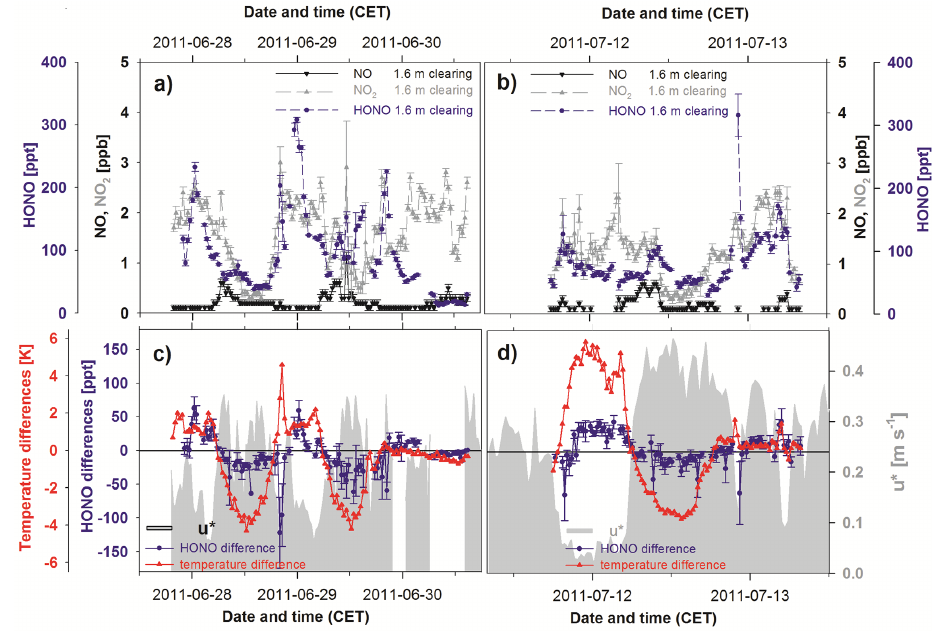
Figure 2. HONO (blue), NO (black) and NO 2 (grey) mixing ratios measured at the clearing at 1.6m averaged for each height interval (i.e. omitting the first data points according to the time resolution of the instruments) from panels (a) 27 June to 30 June 2011 (NO x : 3.5min mean; HONO: 3min mean), and (b) 11 July to 13 July 2011(NO x : 4min mean; HONO: 3min mean). Missing NO values are below the limit of detection (LOD 2 σ = 50ppt). Vertical temperature differences (red triangles and line) and HONO mixing ratio differences (blue dots and line) for each cycle ( ∼ 30min) are shown in panels (c) and (d) as well as the friction velocity (30min mean) in grey shading. Differences of mean HONO values measured at 1.6 and 0.1m are presented and error bars denote combined standard deviations. For temperature, differences between 1.4 and 0.1m are